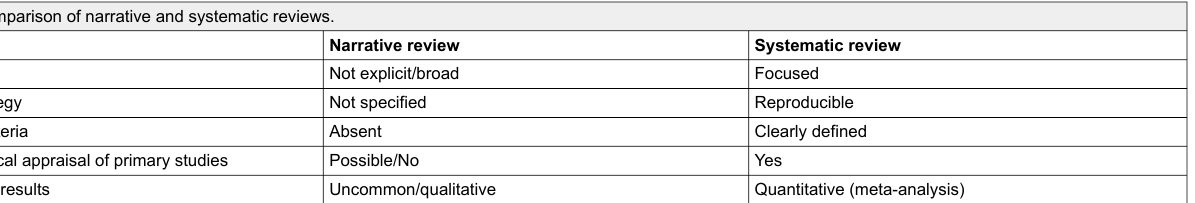
Forest plot of randomised controlled trials comparing the effect of steroids to placebo/usual care for pneumocystis jirovecii pneumonia on mortality. The centre of the squares and the horizontal lines correspond to the relative risk or risk ratio (RR) and 95% confidence intervals (CIs). The area of the squares is proportional to the weight each trial contributes to the meta-analysis. The diamond at the bottom of the graph represents the summary RR and its 95% CI indicating a reduction of 32% (95% CI 6 to 50%) in the risk of death when adjunctive corticosteroids are used in pneumocystistis jiroveci pneumonia. The solid vertical line corresponds to no effect of treatment (RR 1.0). The RR, 95% CI and weights are also given in tabular form (adapted from [48] Briel M, Bucher HC, Boscacci R, Furrer H: Adjunctive corticosteroids for Pneumocystis jiroveci pneumonia in patients with HIV-infection. Cochrane Database Syst Rev. 2006 Jul 19;3:CD006150. Reprinted with the permission from John Wiley and Sons).